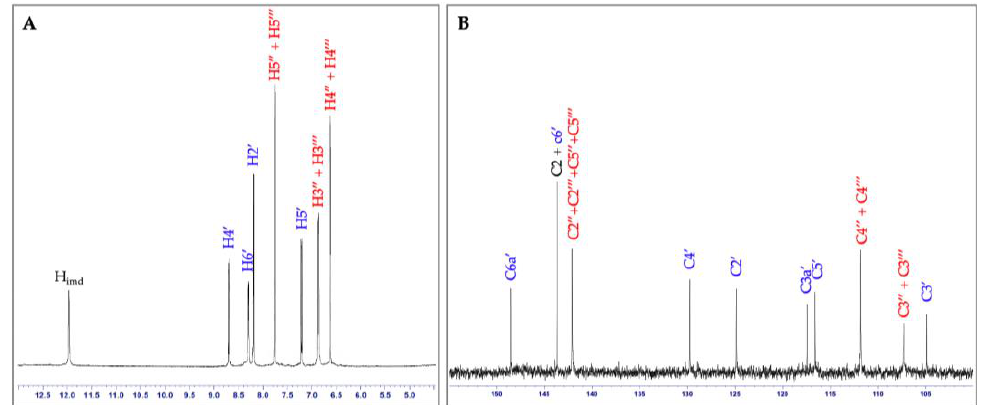
Figure 2. 1 H NMR ( A ) and 13 C NMR ( B ) spectra of imidazole derivative 3 (the colors correspond to the different moieties, as shown in Scheme 1).